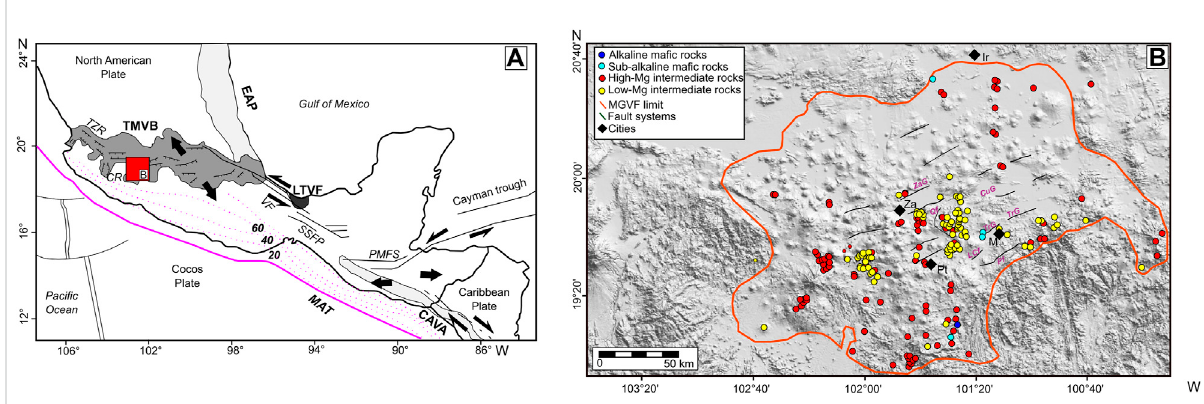
FIGURE 1 (A) Map of the Trans-Mexican Volcanic Belt (TMVB) along with the plate tectonic setting of southern Mexico (modi fi ed after Verma, 2015), showing the MGVF area (red square box). The numbers 20, 40, and 60 represent thedepth in km of the subducted slab beneath thesouthern region of Mexico. Faults and fracture zones: TZR, Tepic-Zacoalco Rift; CR, Colima Rift; ChR, Chapala Rift; TCFS, Tula – Chapala fault system; VF, Veracruz fault; SSFP, Strike-Slip fault province; PMFS, Polochic – Motagua fault system; and GCA, graben of Central America. Abbreviations: T, Tepic; V, Veracruz; EAP, Eastern Alkaline Province; LTVF, Los Tuxtlas Volcanic Field; MAT, Middle America Trench; and CAVA, Central American Volcanic Belt. The thick black arrows represent relative motions at plates. The strike-slip vectors and other normal faults are also shown schematically. (B) Michoacán – Guanajuato volcanic fi eld (MGVF) showing the ma fi c and intermediate volcanic rocks. Abbreviations: M, Morelia; Pt, Pátzcuaro; Ir, Irapuato; Za, Zacapu. TrG, Tarímbaro graben; LCf, La Colina fault; Pf, Paloma fault; CuG, Cuitezeo half graben; ZaG, Zacapugraben; and Qf, Quiroga